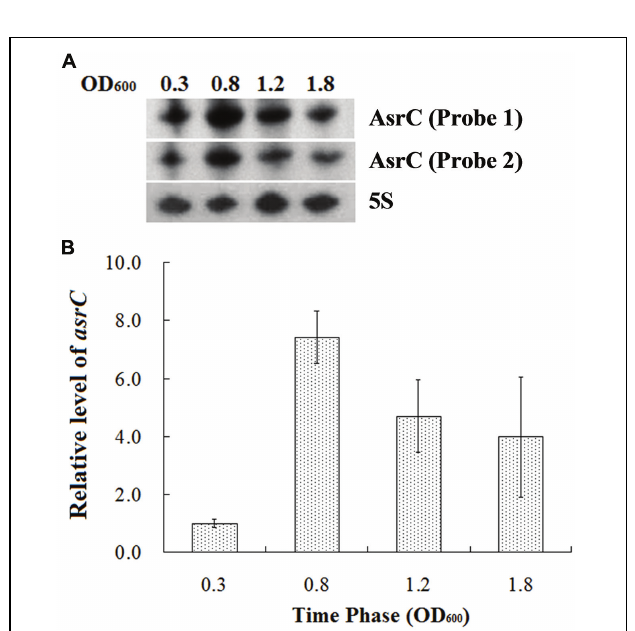
FIGURE 2 | Expression of AsrC at different times. (A) Total RNA was extracted at OD 600 0.3, 0.8, 1.2, and 1.8 and 5 μ g total RNA was loaded into gels, separated on a 7 M urea/6% polyacrylamide gels and transferred to a membranes. Probes 1 and 2 for two regions were used for Northern hybridization. 5S rRNA was the loading control. (B) qRT-PCR to measure AsrC at different times. 5S rRNA was the internal reference.